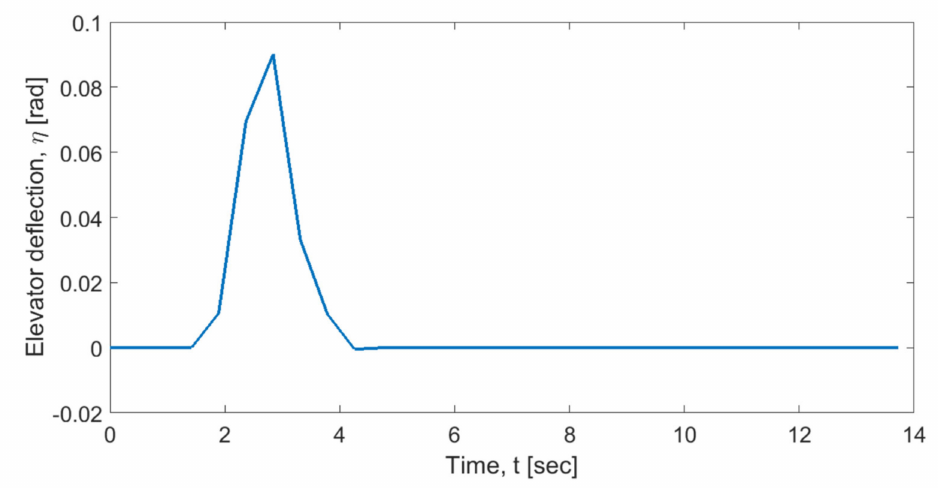
Figure 10. In flight elevator impulse input for short period mode at cruise conditions.